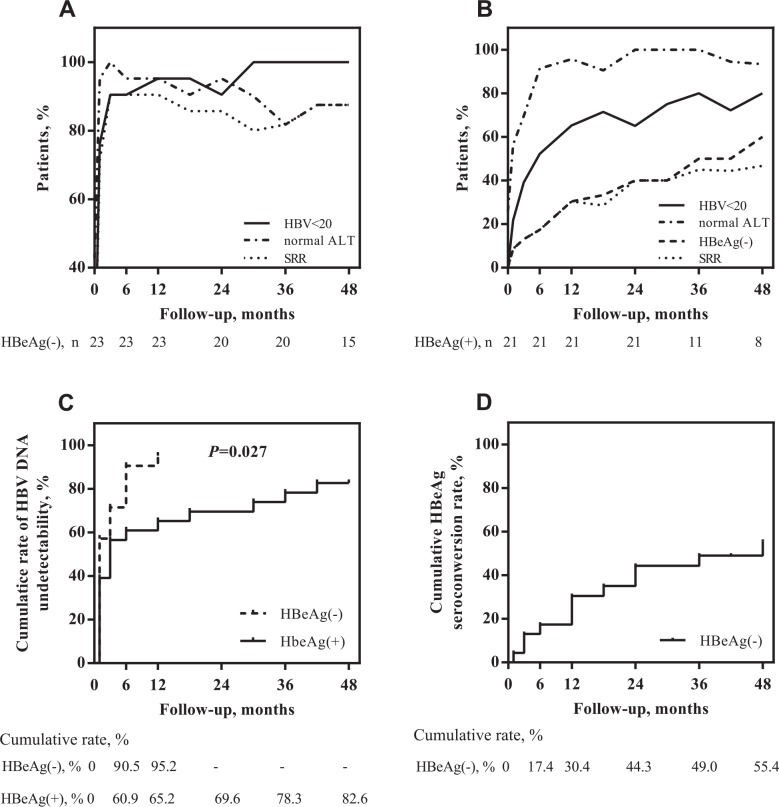
Longitudinal changes in virological, biochemical and serological responses in subsequent months of ETV therapy in HBeAg(+) and HBeAg(-) patients at baseline.Frequencies of HBV DNA <20 IU/mL, normal ALT activity (<40 IU/L), loss of HBeAg and achievement of SRR during ETV therapy in HBeAg(-) (A) and HBeAg(+) (B) patients were calculated. Cumulative rates of viral suppression to undetectable HBV DNA (<20 IU/mL) were determined in patients stratified by HBeAg status (C). The cumulative rate of HBeAg seroconversion was calculated in the subgroup of HBeAg(+) patients (D).